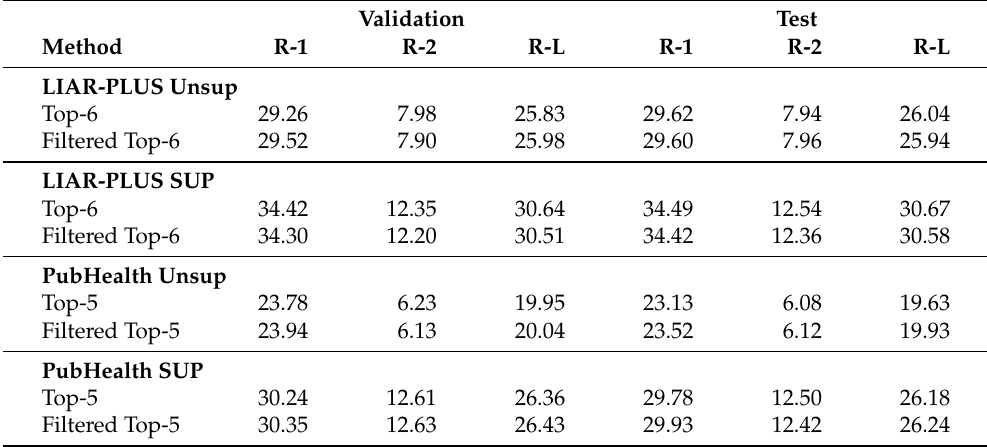
Finally, we remove long sentences and questions from the Ruling Comments, where the ROUGE score changes after filtering are illustrated in Table A7, which results in the Top-N sentences, that are used as input for the post-editing method. Table A7. Sentence clean-up of long sentences for LIAR-PLUS and PubHealth.